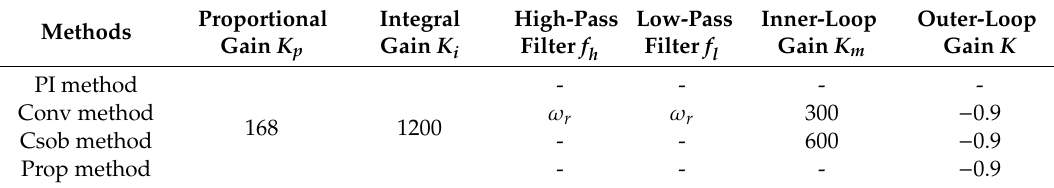
Table 8. Control parameters of these four methods with link-side